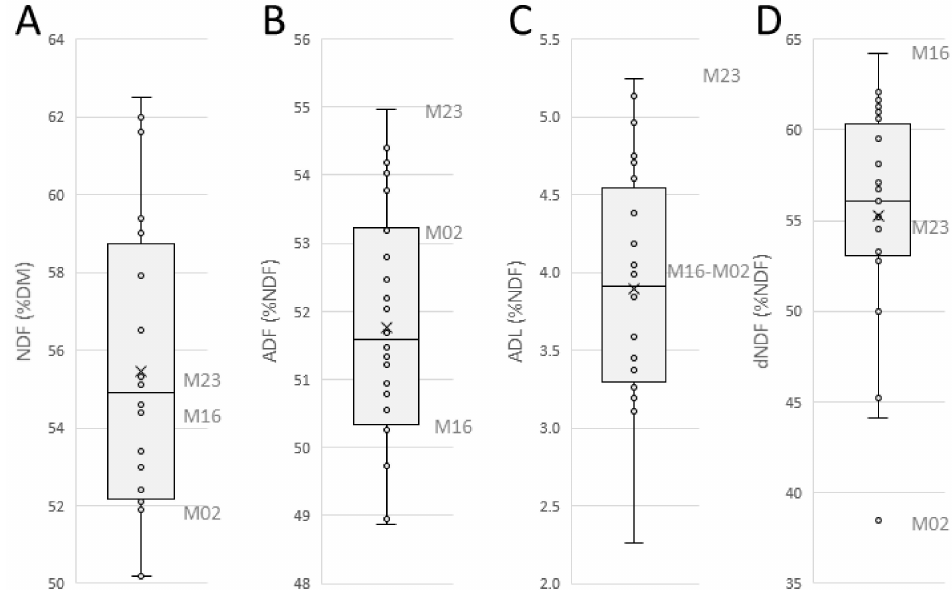
Figure 2. Fiber characteristics of 24 maize inbred lines of maize. ( A ) NDF = Neutral Detergent Fiber (% dm), ( B ) ADF = Acid Detergent Fiber (%NDF), ( C ) ADL = Acid Detergent Lignin (% NDF), ( D ) dNDF = digestibility of the NDF (%